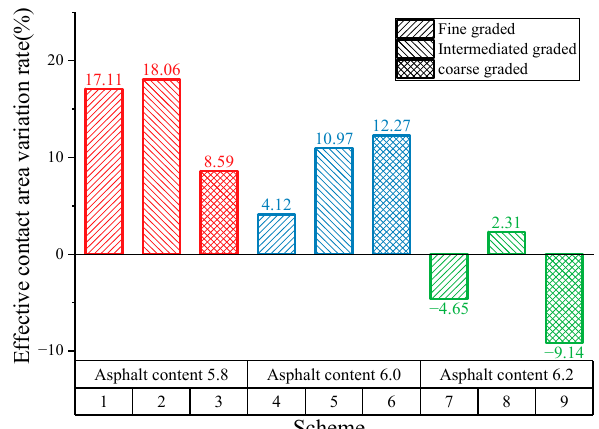
Figure 11. Results for effective contact-area variation rate.